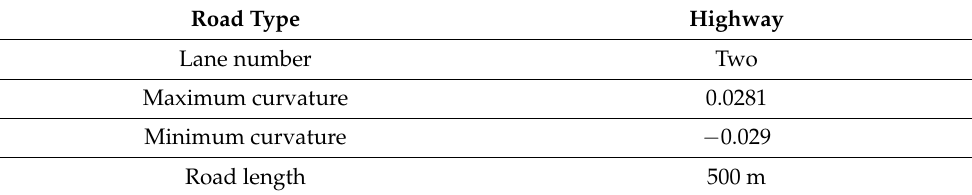
Figure 10. HIL platform.